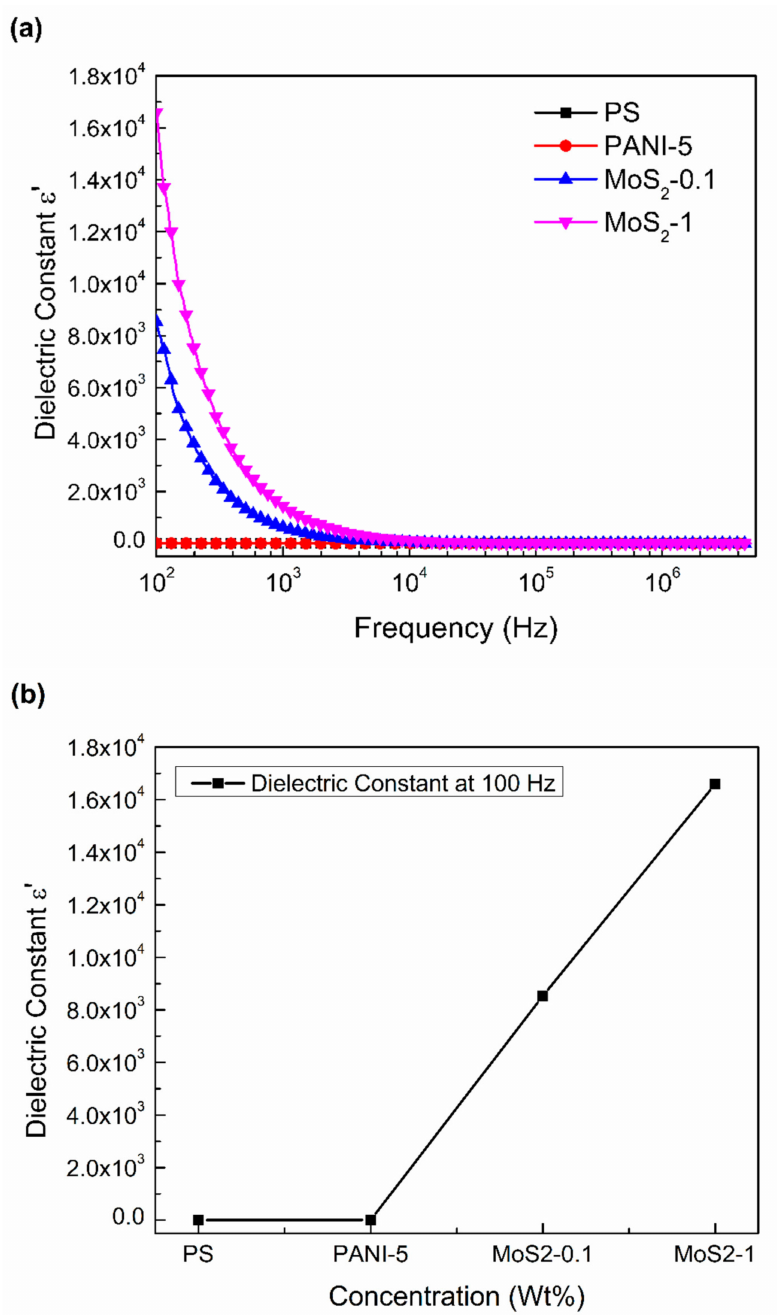
Figure 4. Dielectric constant as a function of frequency of ( a ) PS, PANI, PS / PANI-5 wt % polymer blend, and PS / PANI / MoS 2 hybrid polymer composites. Dielectric constant for ( b ) PS, PANI, PS / PANI-5 wt % polymer blend, and PS / PANI / MoS 2 hybrid polymer composites at 100